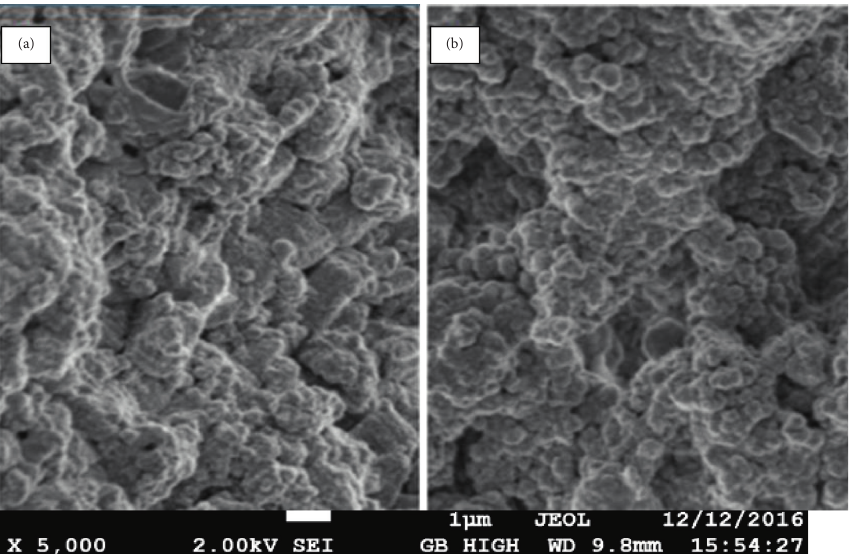
Figure 2: Microstructures of chicken meat fermented with P. nalgiovense (a) and P. chrysogenum (b) observed with SEM. Samples from ten pieces of chicken meat for each treatment were examined.